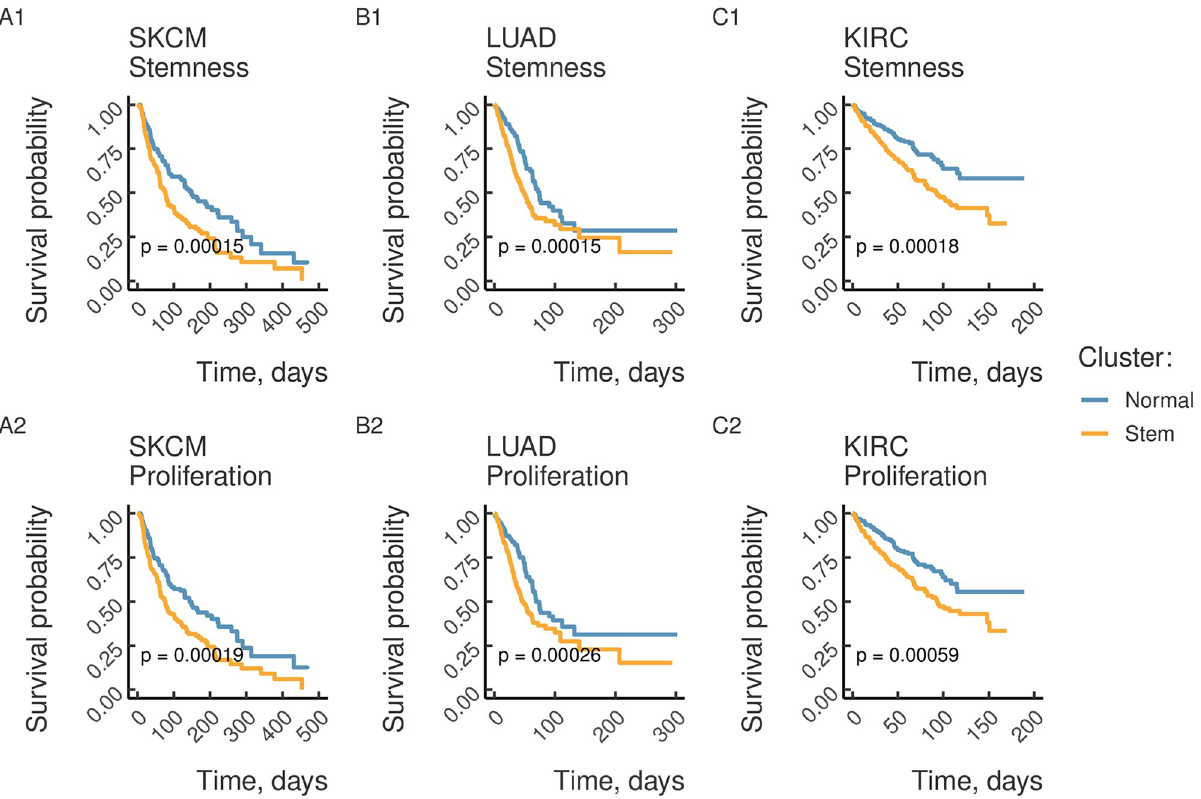
Fig 6. Intertumor heterogeneity of stemness and proliferation is predictive of poor survival. Kaplan-Meier survival curves grouped by clustering according to stemness (proliferation) signature are plotted for skin melanomas (A), lung adenocarcinoma (B) and renal clear cell carcinoma (C). P- values from the logrank test are reported. The notation for cancer types as in Fig